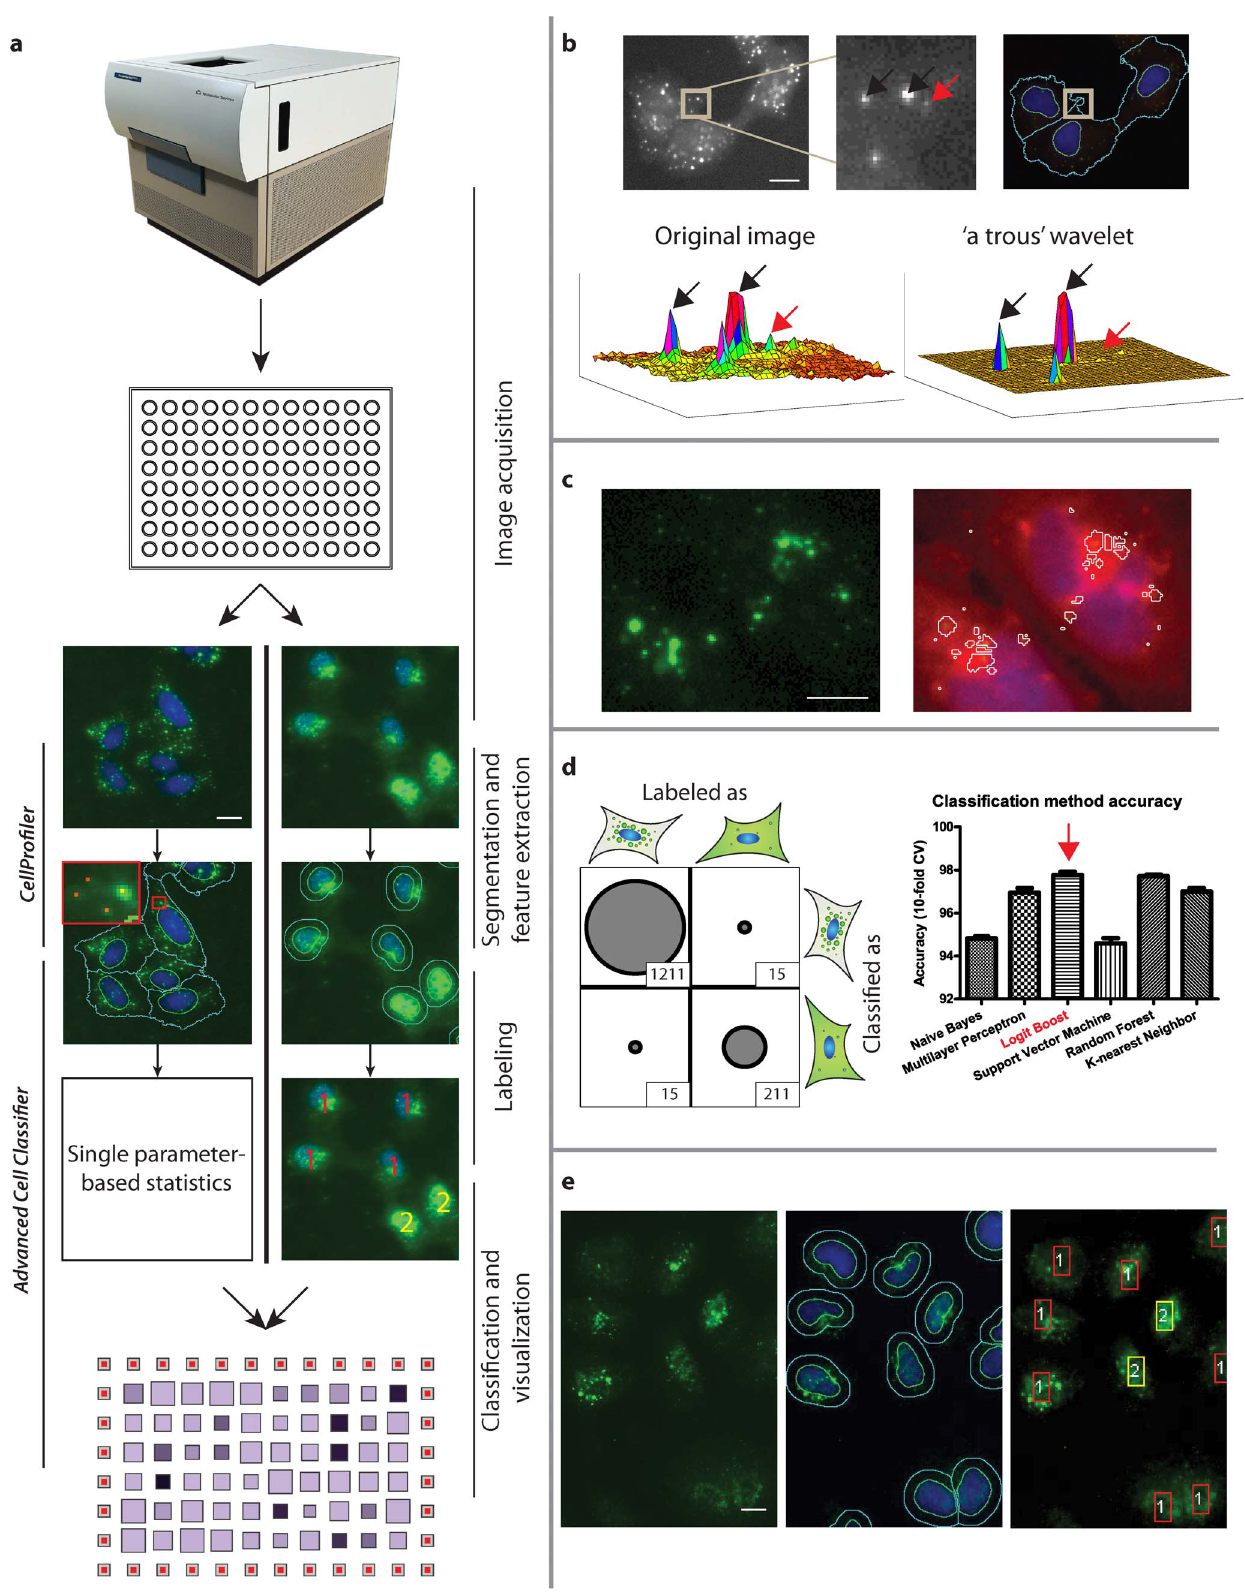
Figure 2. Data analysis steps. (a) Data analysis pipeline. Alternative concepts: (left column) single parameter-based statistics, (right column) machine learning. (b) Spot detection for the EE assay. Spot intensities with the desired size (black arrows) were amplified, while noise (red arrow) and uneven background was suppressed. (c) Analysis of the EA and EF assays. GFP intensity was thresholded, and the detected objects were filtered by